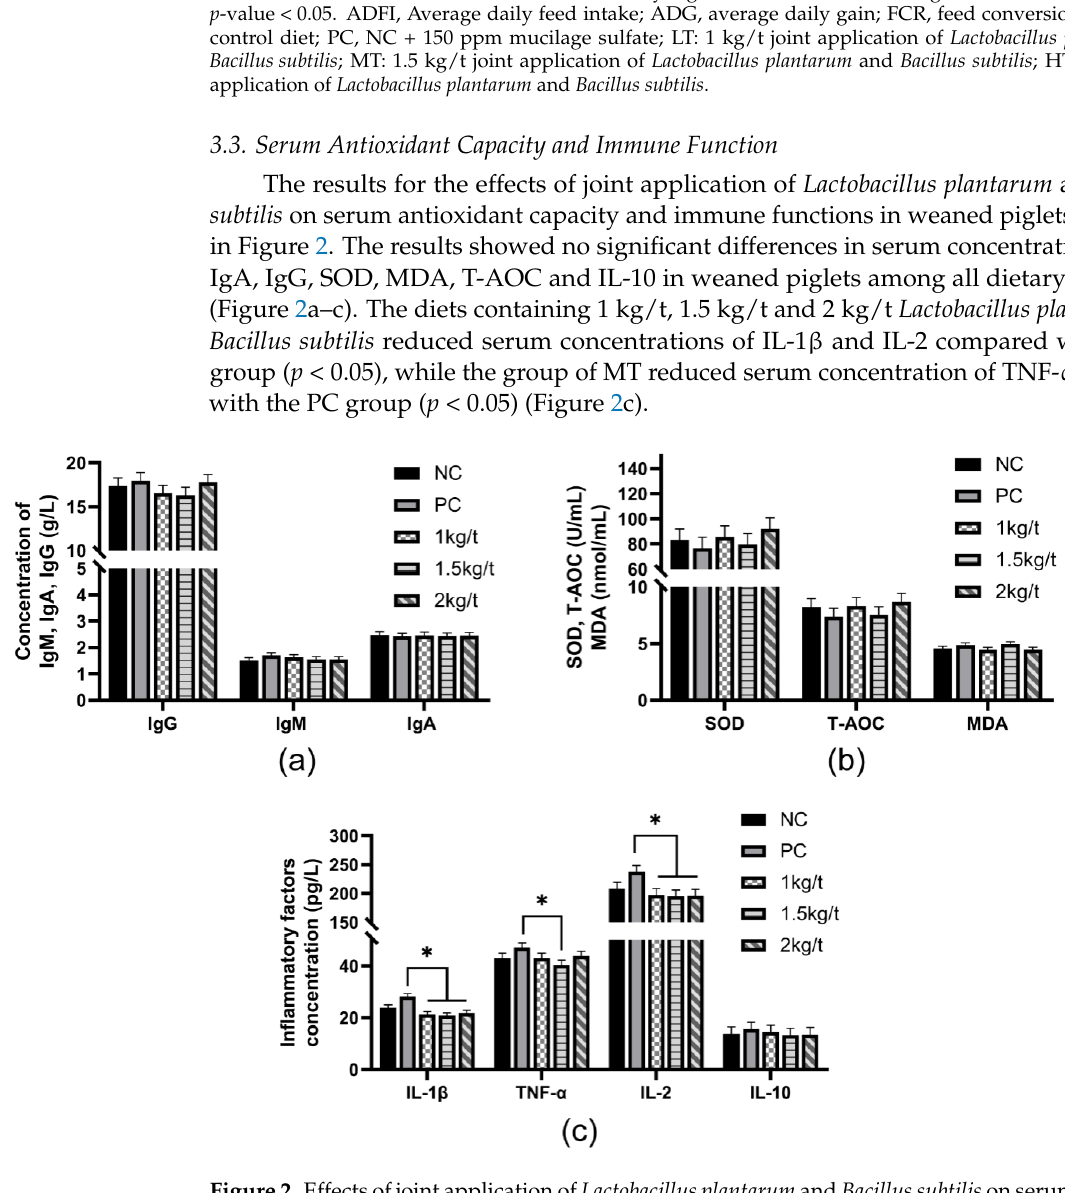
Figure 2. Effects of joint application of Lactobacillus Plantarum and Bacillus subtilis on serum antioxi- dant capacity and immune function in weaned piglets. ( a ) The serum concentration of immuno- globulin in weaned piglets. ( b ) Serum concentrations of antioxidant-related substances in weaned piglets. ( c ) The serum concentration of inflammatory factors in weaned piglets. “*” means there were statically significant differences ( p < 0.05). NC, a control diet; PC, NC + 150 ppm mucilage